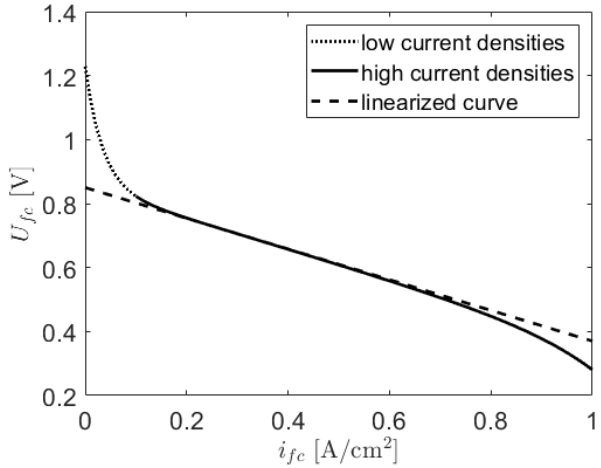
Figure 2. Polarization curve for a given